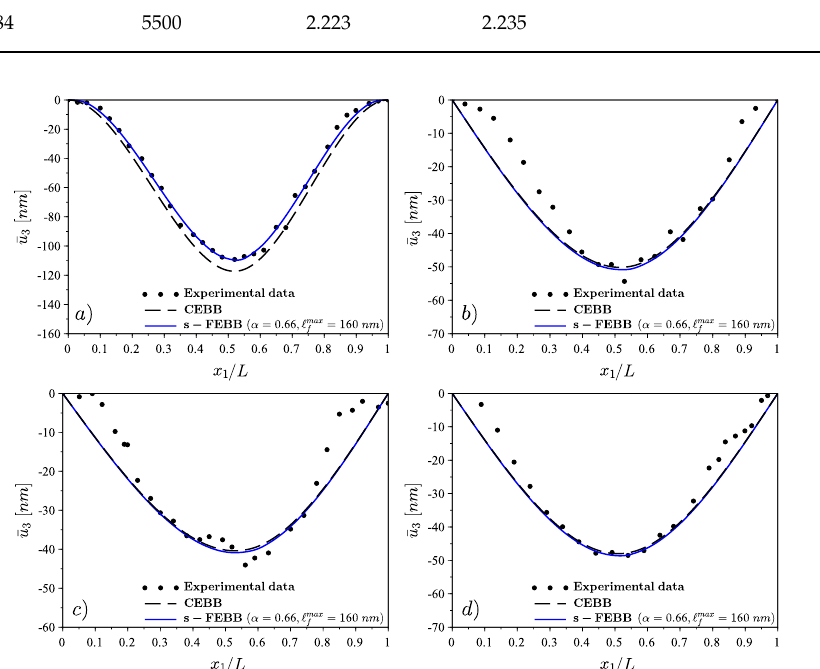
Figure 11. The comparison of experimental measurements [37] (deflections) of GaN nanobeams vs. the classical model (CEBB) and s-FEBB model: ( a ) fixed scheme and ( b – d ) simply supported scheme, for load position depending on data in Table 5 (see also Equation (14 1 )).